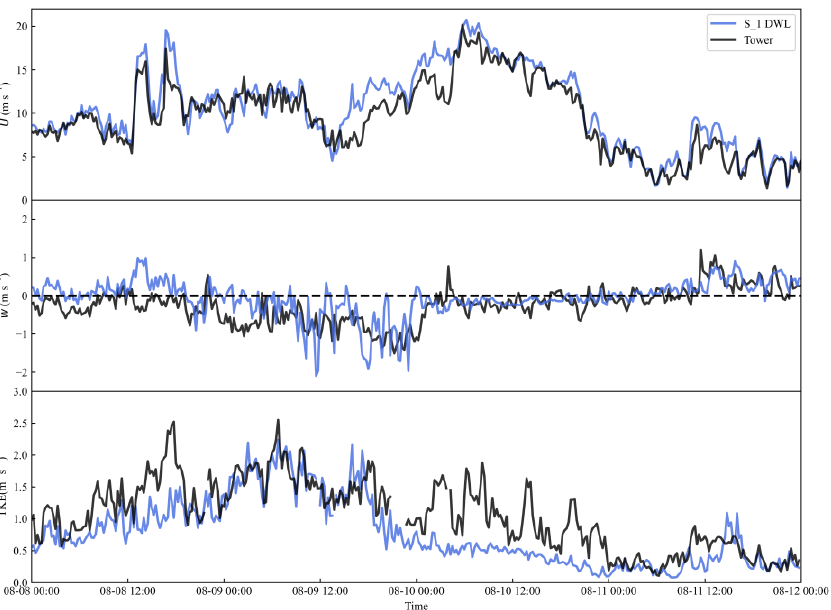
Figure 3. Time series of 15 min average horizontal wind speed ( U ), vertical wind velocity ( w ), and turbulent kinetic energy (TKE) from S_1 and the tower.